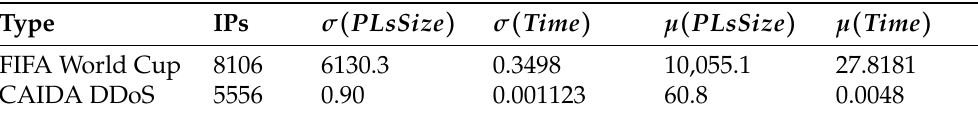
Table 8. Parameters calculated for DDoS attack and FC